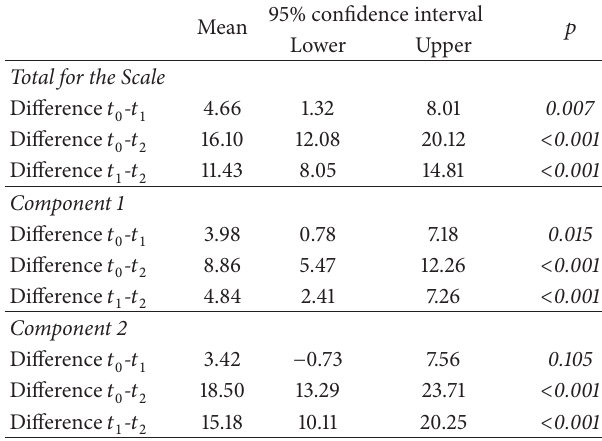
Table 2: Sensitivity to